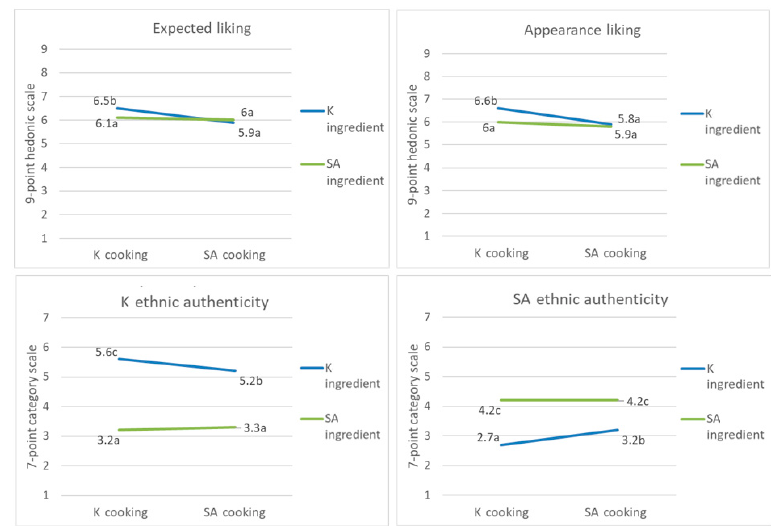
Figure 2. Effect of the ( a ) nationality × cooking process on K and SA ethnic authenticity and ( b ) nationality × plating on the expected liking and K ethnic authenticity.